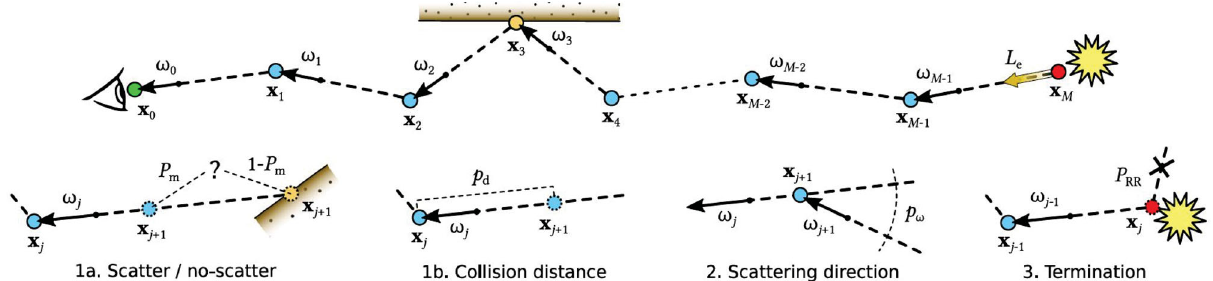
Fig. 11 Above: example path containing volume (blue) and surface (yellow) vertices. Note that, in the path tracing algorithm, the path carries visual importance, and this is generated in the opposite direction to the flow of light. Below: the four zero-variance sampling decisions considered. Optimal decisions are whether to scatter within or outside the medium, how far to travel until the next scattering event, how to choose the scattering direction, and when to terminate the path. Reproduced with permission from Ref. [3], c (cid:2) The Author(s) 2019.